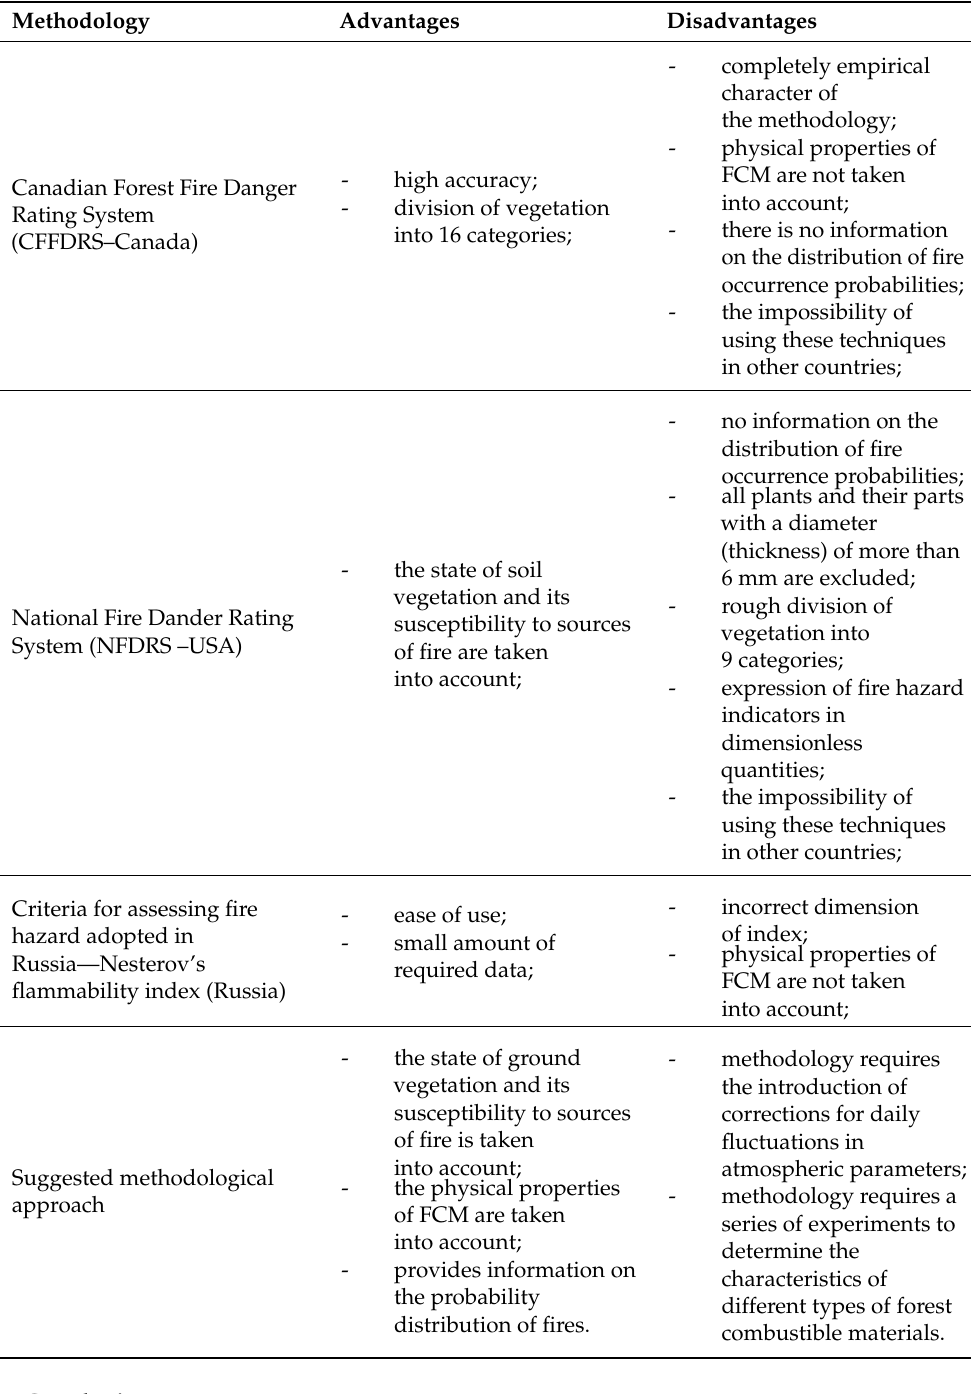
Table 7. Comparison of the main methodologies with the proposed methodological